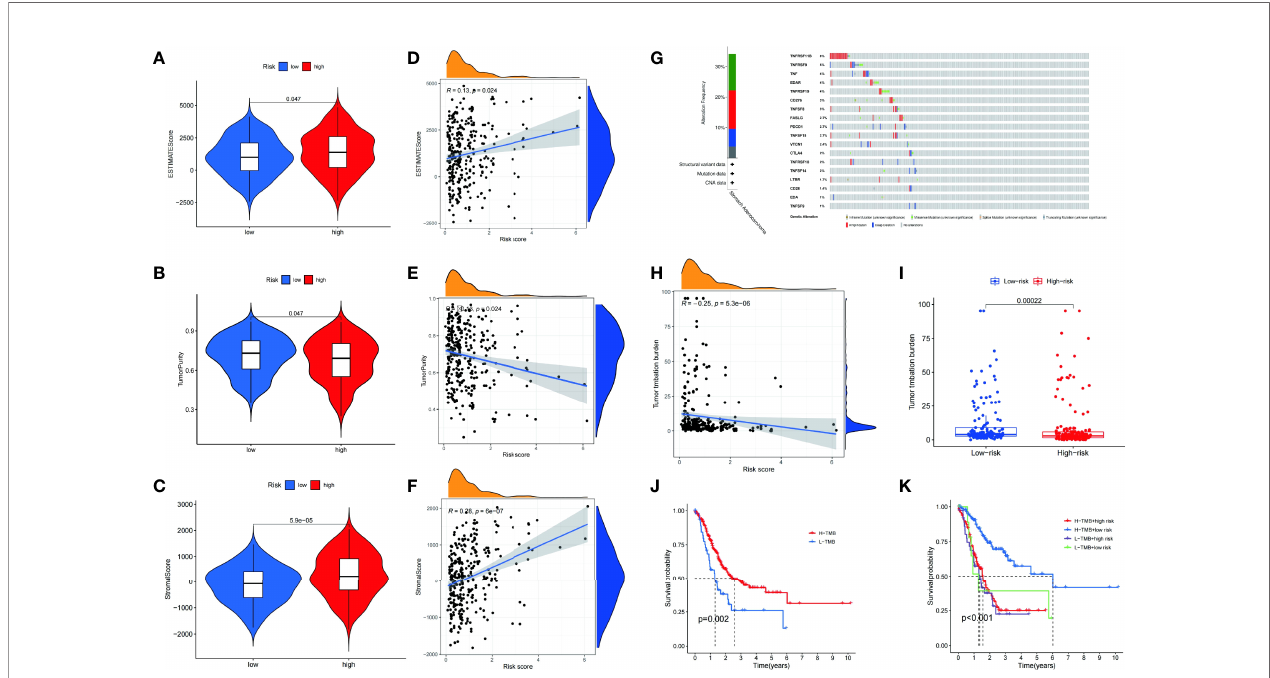
FIGURE 7 | The estimate scores (A) , tumor purity (B) , and stromal scores (C) differed between the high- and low-risk patients. Spearman correlation analysis of the risk scores, estimate scores (D) , tumor purity (E) , and stromal scores (F) . Genetic mutations: types and frequencies (G) . Spearman correlation analysis of tumor mutation burden (TMB) and risk score (H) . Difference in TMB between the high- and low-risk patients (I) . Kaplan – Meier curve for the overall survival of the high- and low-TMB patients (J) . Kaplan – Meier curve for the overall survival of the high-TMB/high-risk, high-TMB/low-risk, low-TMB/high-risk, and low-TMB/low-risk patients (K)